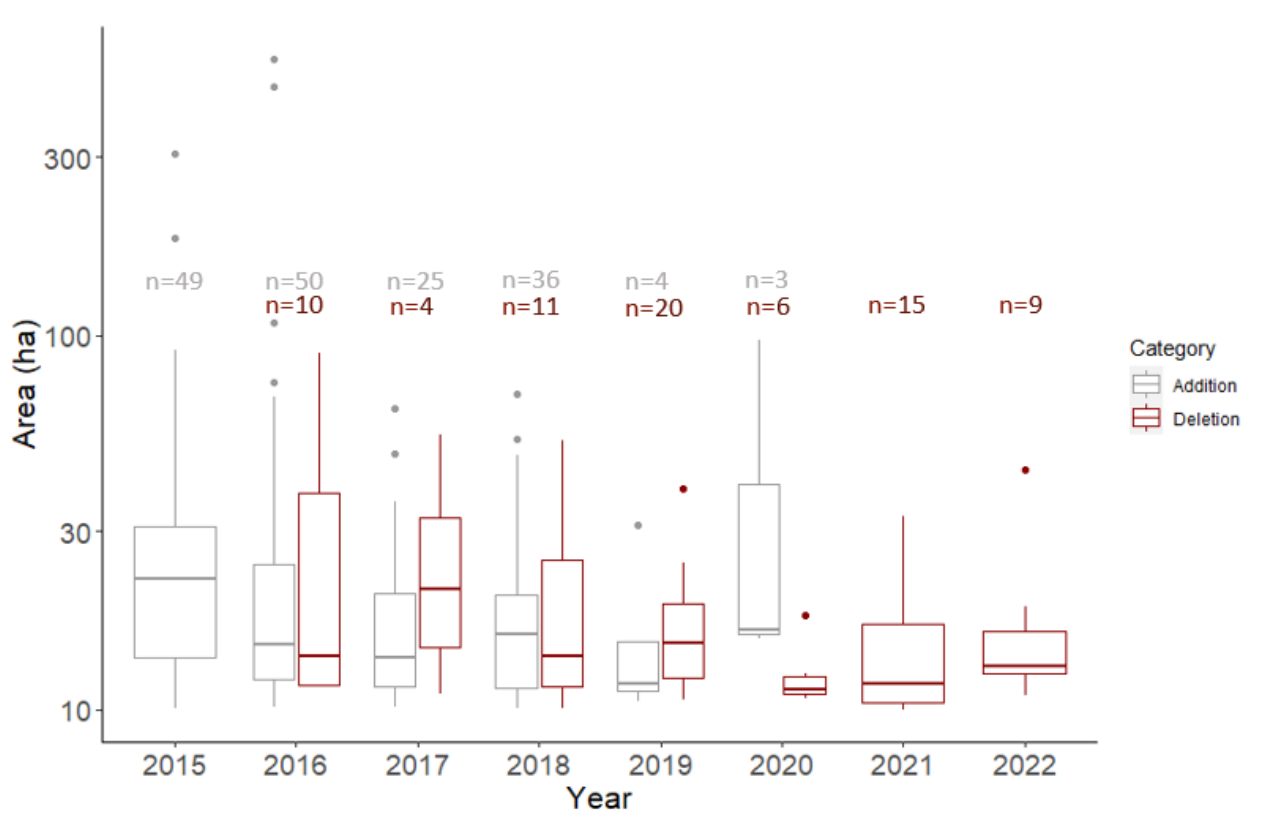
Figure 5. Boxplots of the area of wildfires which were added and removed (in the refining pro- cess) compared to the original INPA database. The term n is the number of wildfires that were added/removed to each year in the unified database. The years 2021 and 2022 are not shown in the addition category, as we did not identify wildfire events which were missing in the INPA